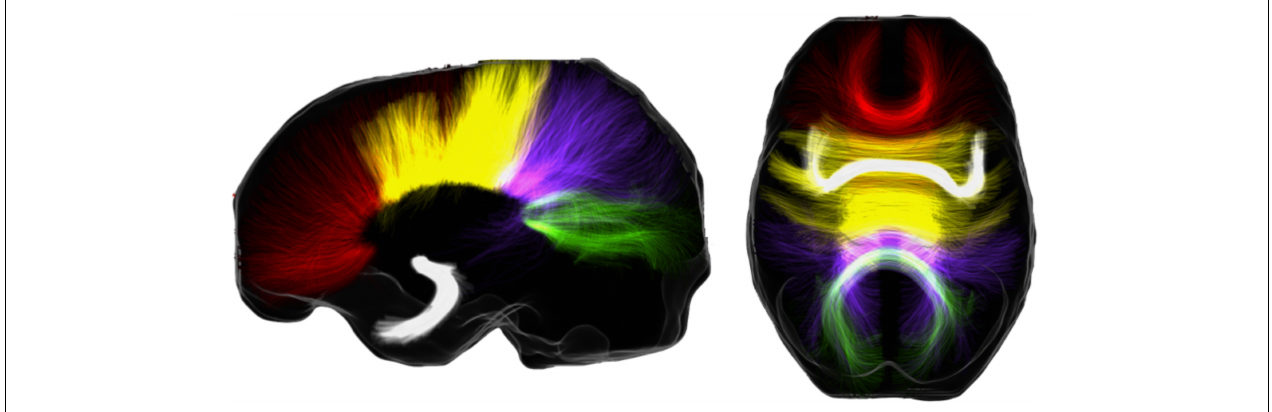
FIGURE 1 | Sagittal (left figure) and axial view (right figure) of the 2 main interhemispheric tracts in humans overlaid on a population template. The tracts included are the corpus callosum with its four geometrical subdivisions (rostrum and genu, in red; truncus or body, in yellow; isthmus, in violet; splenium, in green) and the anterior commissure (in